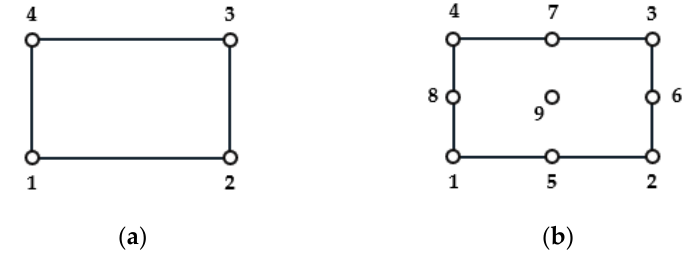
Figure 7. Plate elements from Lagrange family: ( a ) bilinear element; ( b ) biquadratic element.